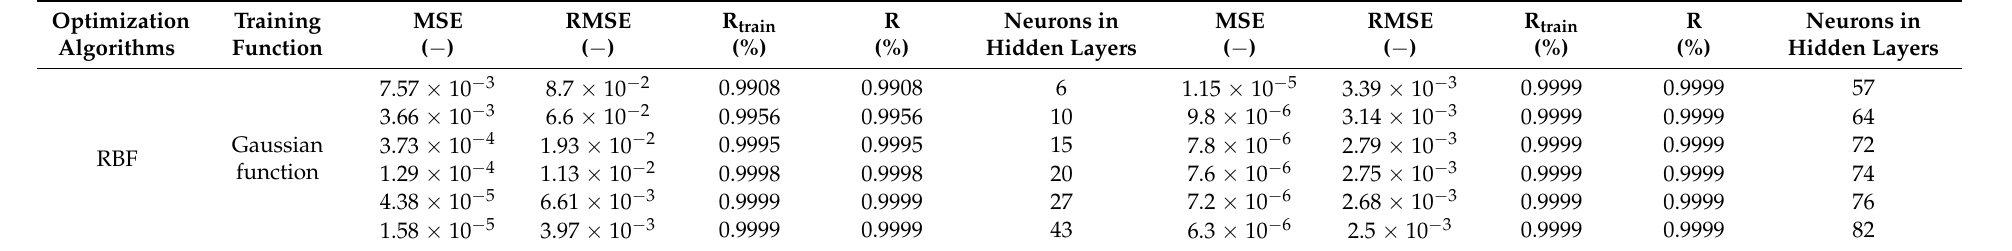
Table 5. Accuracy prediction of DRI ANN structures using RBF model algorithms, according to the number of neurons studied and the optimal MLP